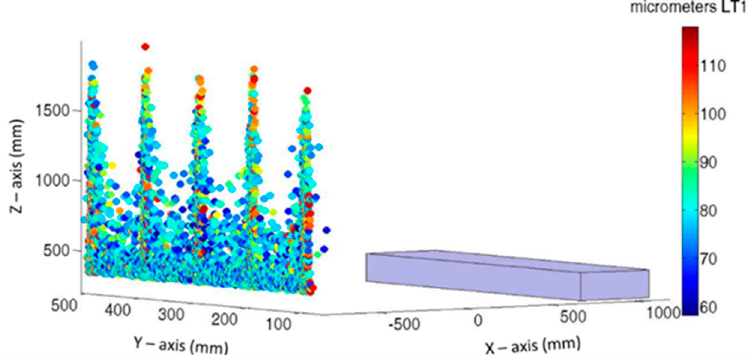
Figure 9. Best LT position and maximum error obtained on each Monte Carlo test: Y-axis direction.